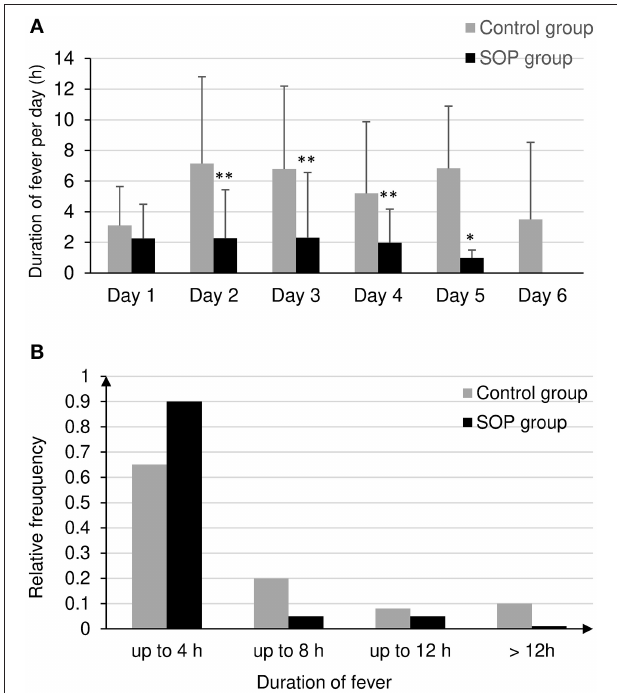
Median temperature before intervention, ◦ C ( ± SD)